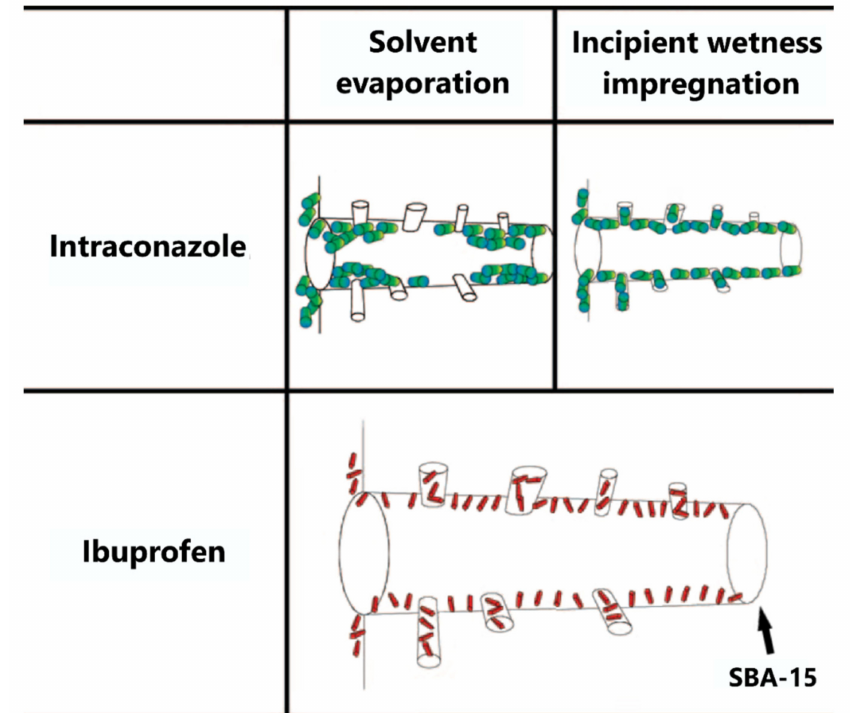
Figure 2. Physical state of itraconazole and ibuprofen upon association with SBA-15 loaded according to the solvent evaporation method and incipient wetness impregnation method. Adapted with permission from [57], Copyright 2008 American Chemical